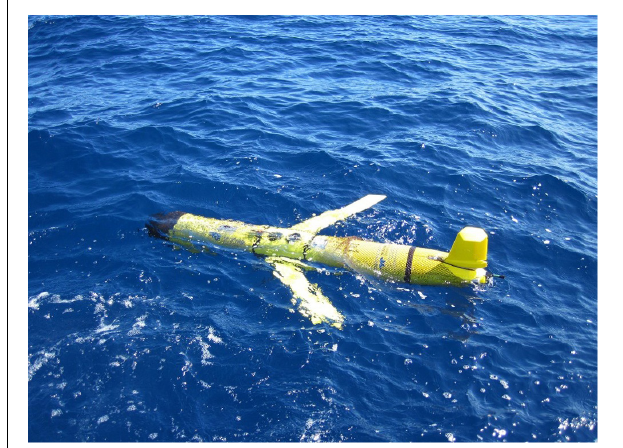
FIGURE 5 | Slocum glider during DP02 cruise